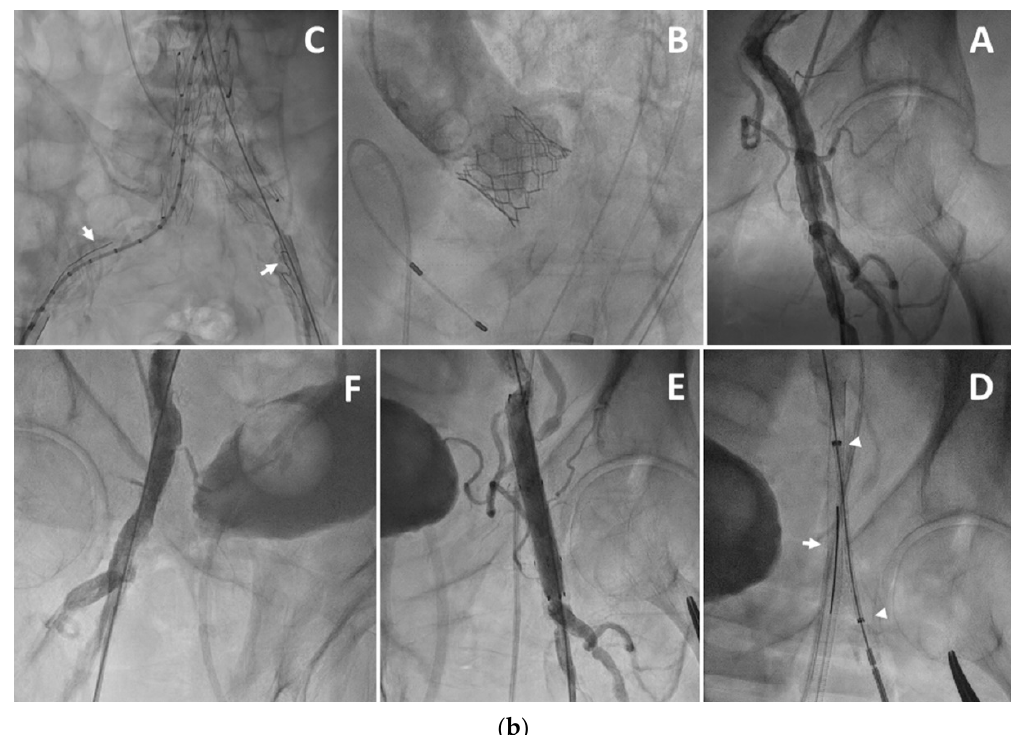
Figure 3. Primary VCD failure. A 90-year-old male with peripheral vascular disease was diagnosed with severe symptomatic aortic stenosis and an abdominal aortic aneurysm. ( a ) CT angiography revealed an infra-renal aortic aneurysm and diffusely calcified ileofemoral arteries with a minimal lumen diameter of 6.0 mm. ( b ) A combined TAVR and endovascular aneurysm repair (EVAR) procedure was performed. 5Fr sheaths were inserted into both superficial femoral arteries, through which two 0.014” safety wires were delivered to the aorta. Pre-closure with Proglide vascular closure devices was performed in the right femoral artery; however, vascular calcification precluded Proglide deployment in the left femoral artery ( A ). Implantation of a 29 mm Sapien S3 valve ( B ) was followed by EVAR ( C ) (safety wires within the femoral arteries marked with arrows). A 9 × 60 mm Fluency stent graft (between arrowheads) was positioned parallel to the 14Fr sheath (arrow) in the left femoral artery prior to sheath removal ( D ) and deployed following sheath removal ( E ). Proglide devices achieved vascular closure of the right femoral artery following removal of the 18Fr sheath ( F ).